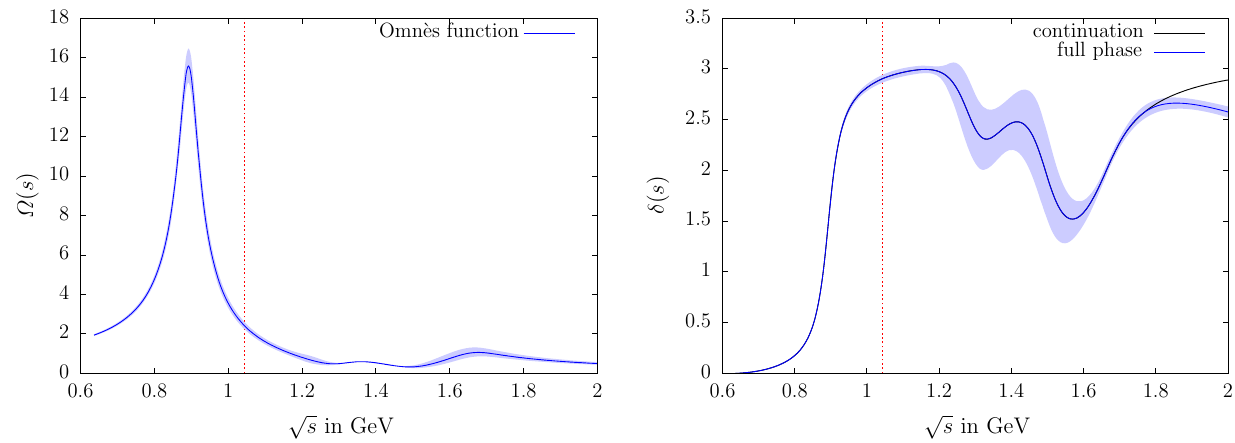
Fig. 5 Absolute value and phase of the Omnès function for the isospin I = 1 / 2 P -wave K π scattering phase shift. The dashed red line indicates the K η threshold. The phase incorporates the higher resonances K ∗ ( 1410 ) and K ∗ ( 1680 ) and is continued towards π starting at shown in the black